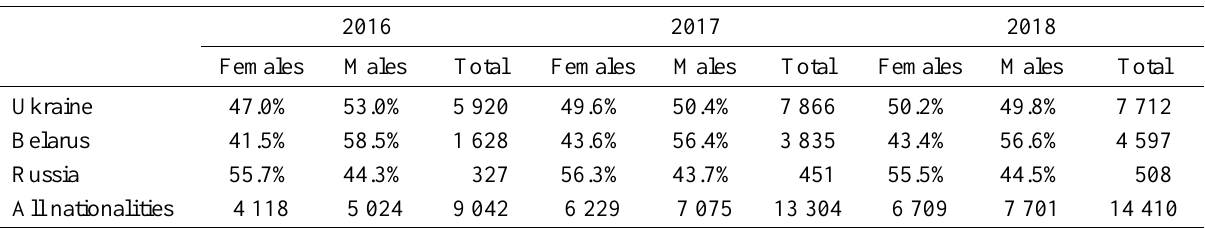
Table 1. Permanent residence permits issued,